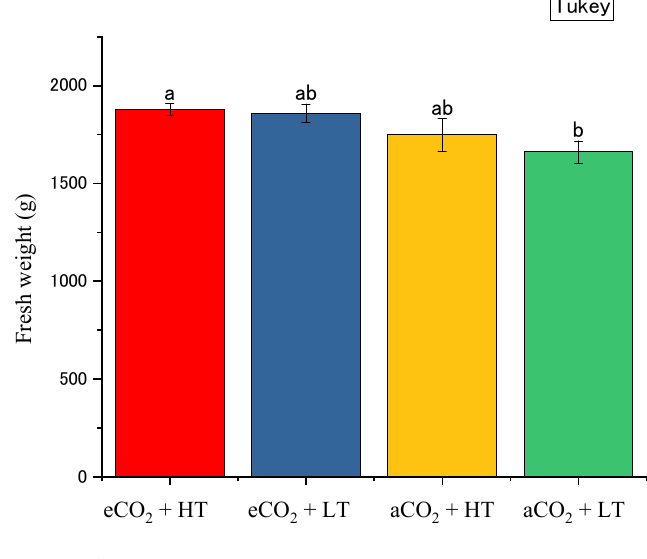
Figure 5. Fruit fresh weight at different harvesting dates under aCO 2 + LT, aCO 2 + HT, eCO 2 + LT, and eCO 2 + HT treatments ( n = 6). Error bars indicate SE of mean. Different lowercase letters indicate significant differences among treatments ( p < 0.005).